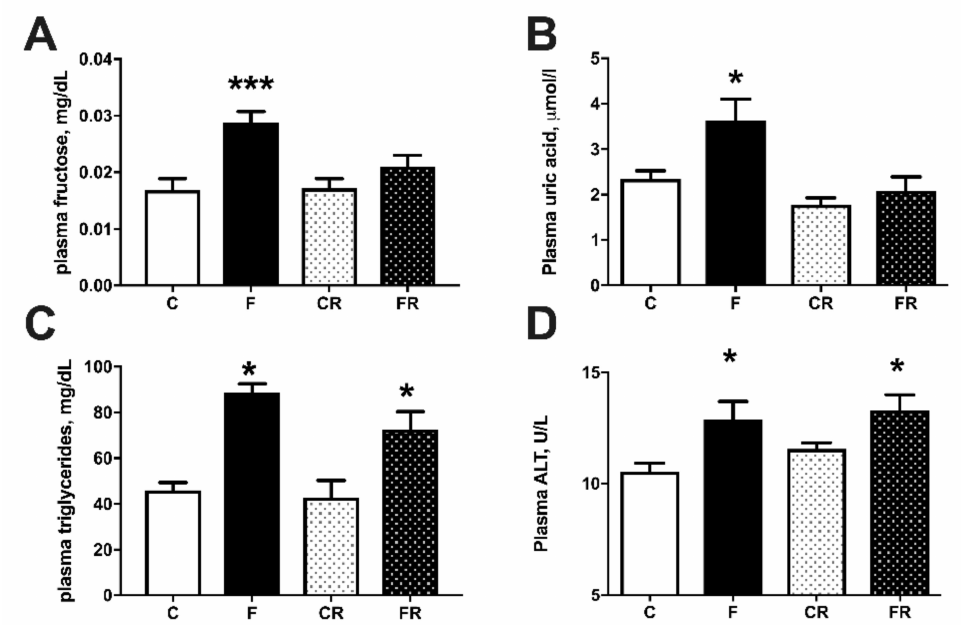
Figure 4. Plasma metabolic parameters: fructose ( A ), uric acid ( B ), triglycerides ( C ), and alanine aminotransferase (ALT) ( D ), in control (C), fructose (F), control rescue (CR) and fructose rescue (FR) rats. Values are the means ± SEM of eight different rats. * p < 0.05, *** p < 0.001 compared to respective control (one-way ANOVA followed by Tukey post-test).